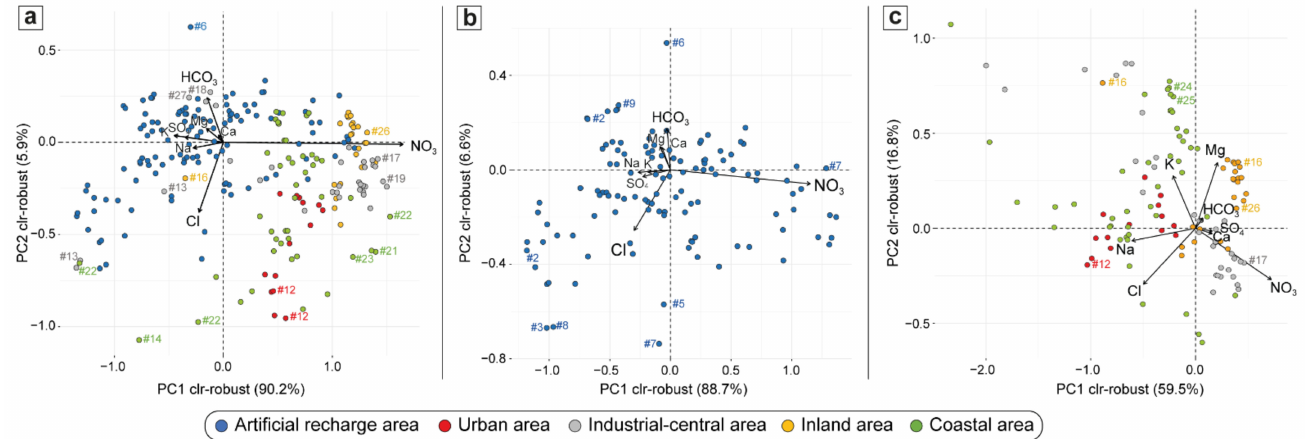
Figure 3. Robust compositional biplot of major species for: ( a ) all the investigated wells; ( b ) artificial recharge area (ARA) wells; and ( c ) alluvial plain (AP) wells. Scores are represented with different colors according to wells’ location. Variable labels in the plot represent the clr-transformed data of the corresponding